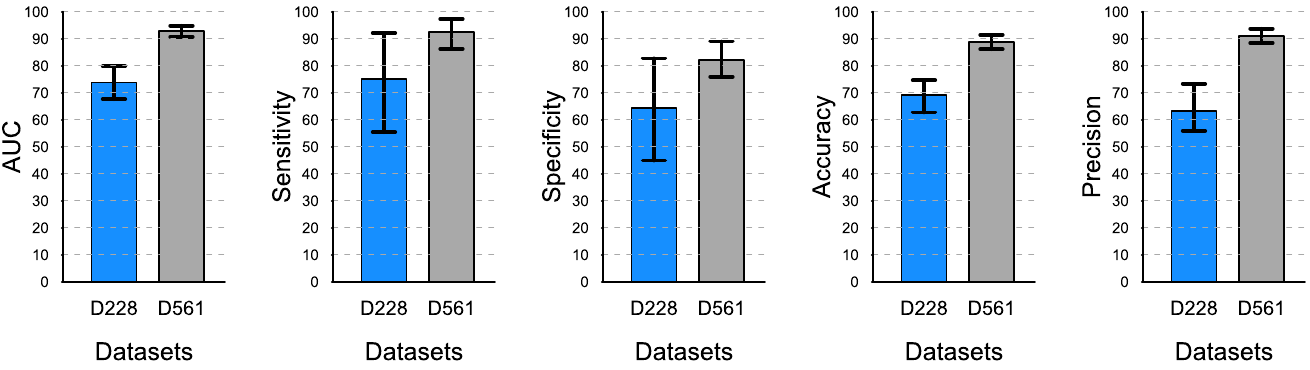
Fig 7. Classification performance of the same assay using the two TSI distributions from the empirical datasets. With u = 0.2, h = 500, recency at 6 months. The 95% prediction bounds are obtained from 1000